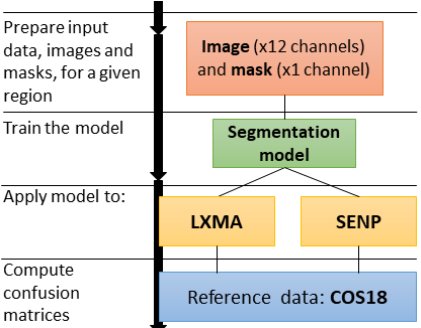
Figure 3 . Overview of the several steps of the method for a given region (LXMA/SENP). For each region a segmentation model is trained and tested for both regions using as reference